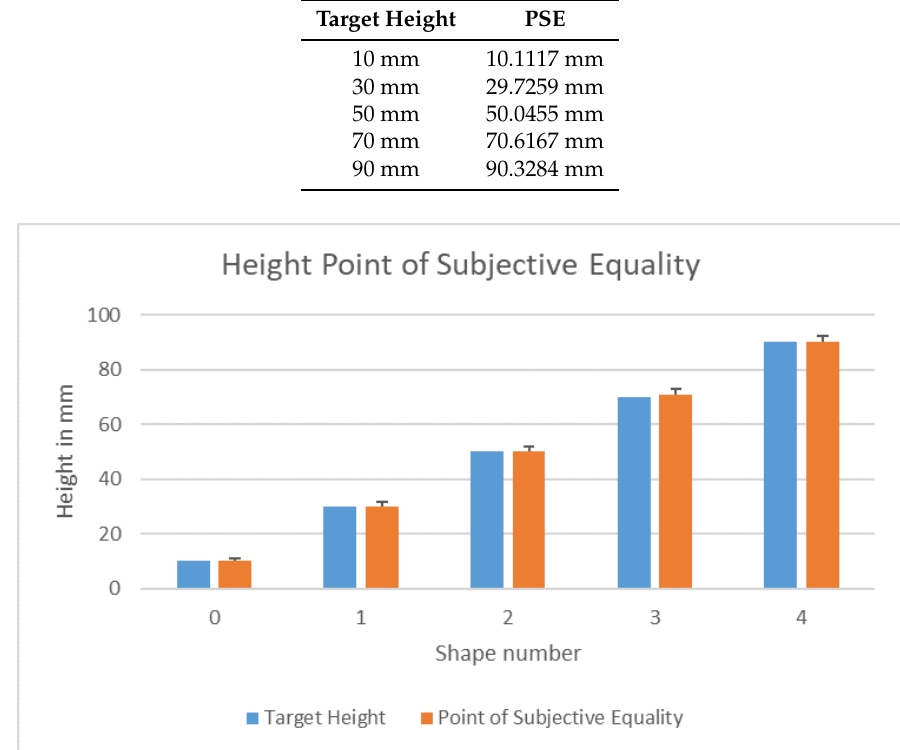
Figure 7. Point of subjective equality for the height judgement